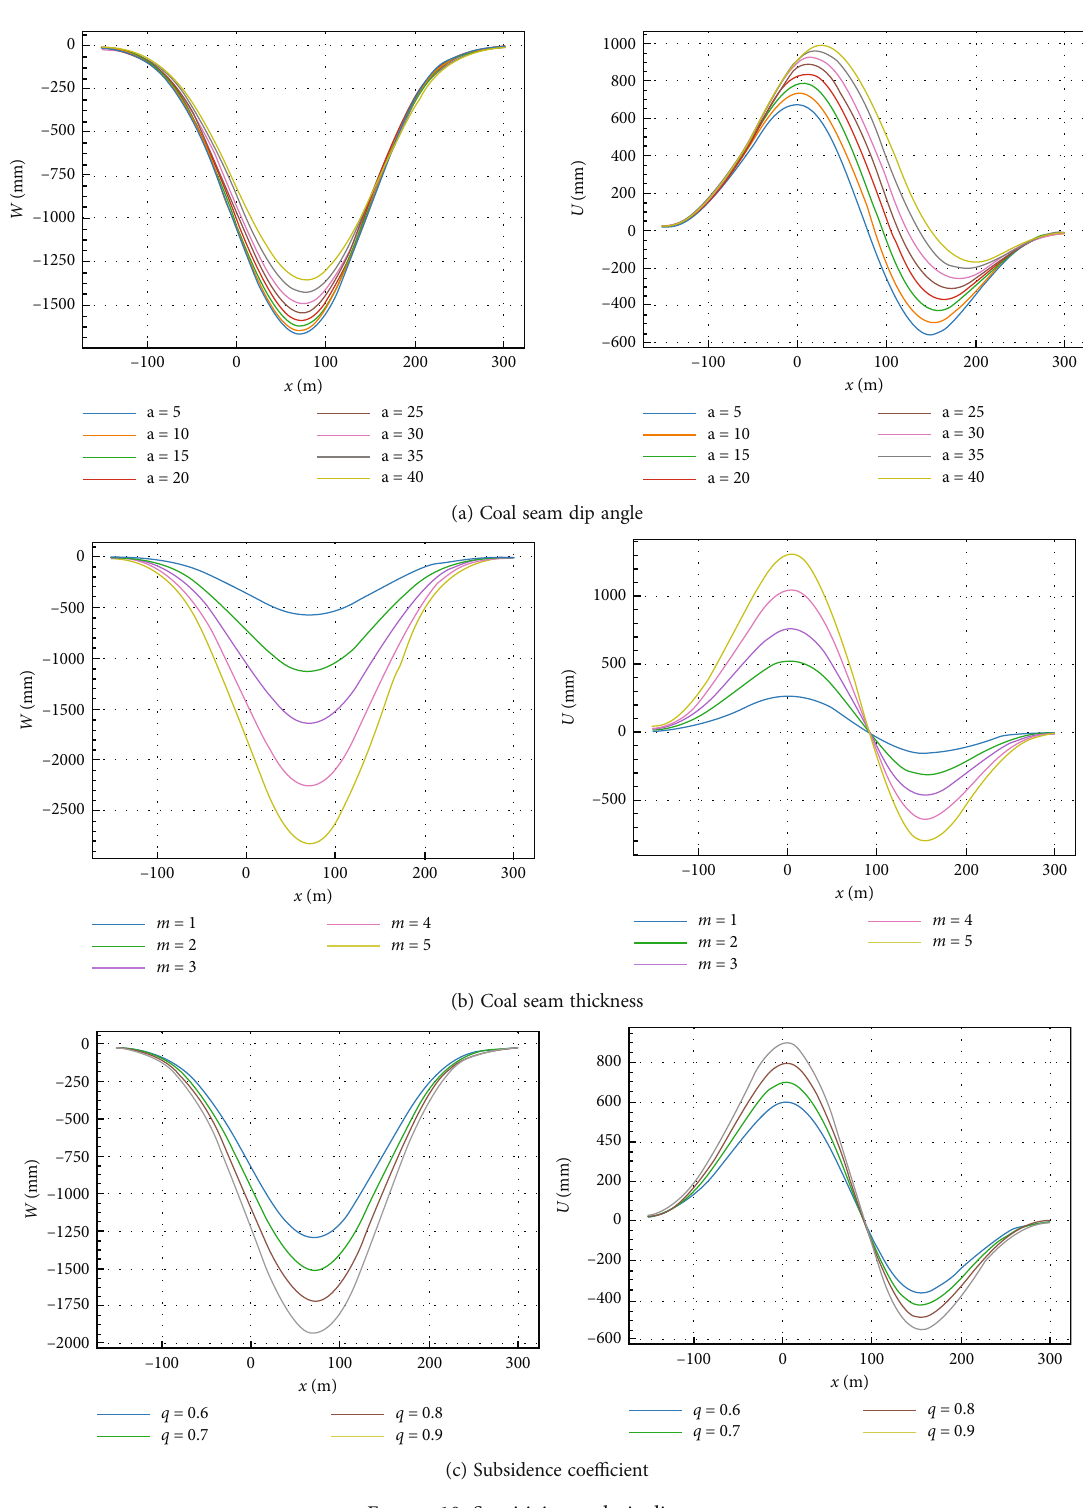
Figure 10: Sensitivity analysis